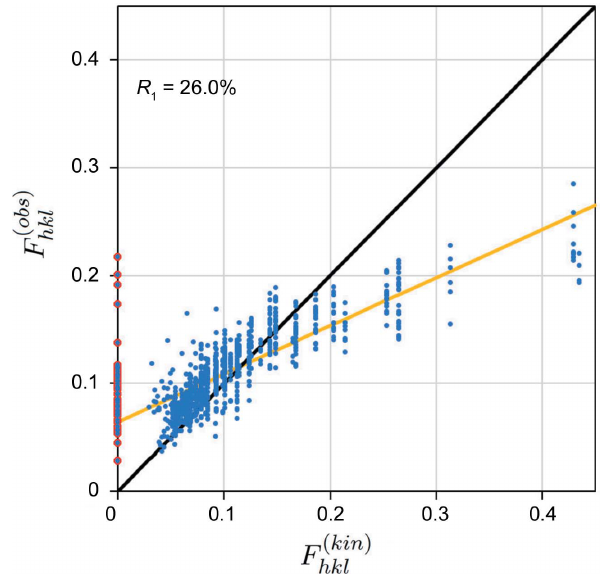
Figure 4 R 1 calculation for cRED silicon data using the kinematic model [equation (1)] with B = 0.2. Kinematically forbidden reflections are highlighted in red. R 1 =